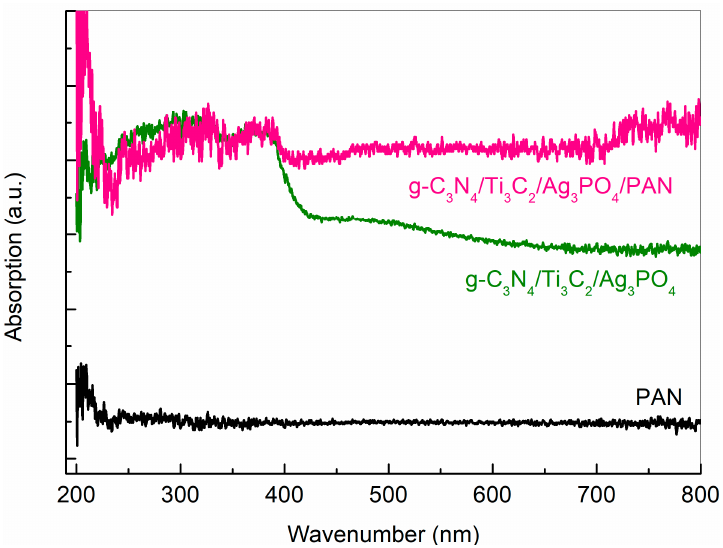
Figure 3. DRS spectrum of PAN, g-C 3 N 4 /Ti 3 C 2 /Ag 3 PO 4 and g-C 3 N 4 /Ti 3 C 2 /Ag 3 PO 4 /PAN.